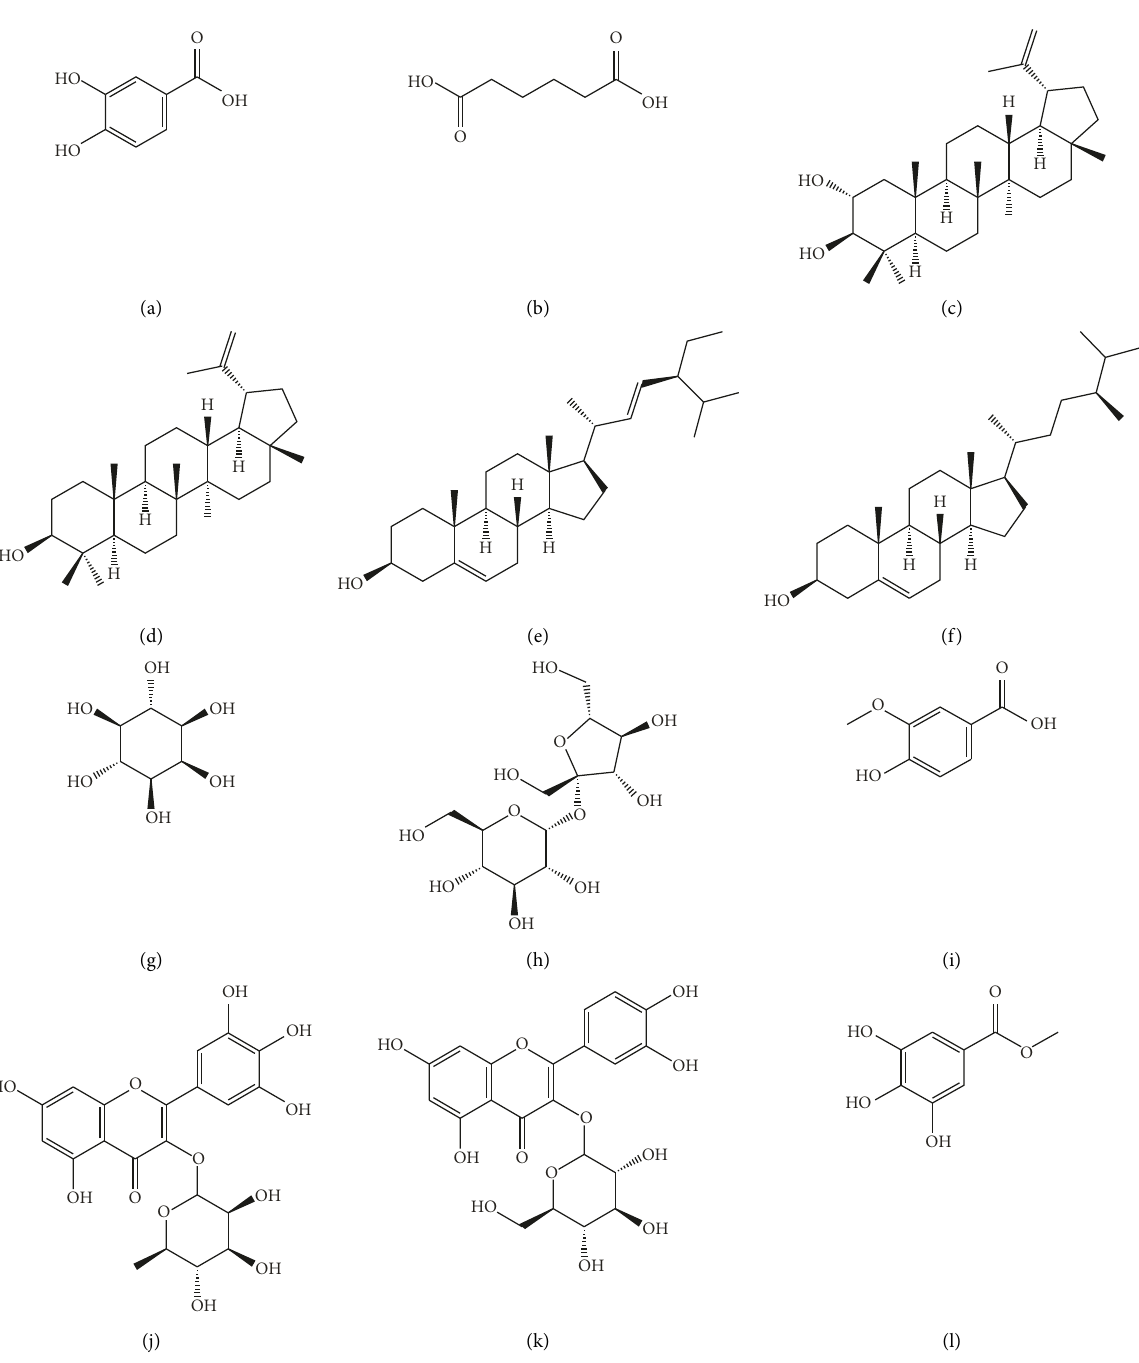
Figure 2: Compounds responsible for the biological activity of the Detarium microcarpum : (a) protocatechuic, (b) hexanedioic acid, (c) Lup-20 (29)-ene-2alpha, 3beta-diol, (d) lupeol, (e) stigmasterol, (f) campesterol, (g) myo-inositol, (h) sucrose, (i) vanillic, (j) myricetin 3-O-rhamnoside, (k) quercetin 3-O-glucoside, and (l) methyl